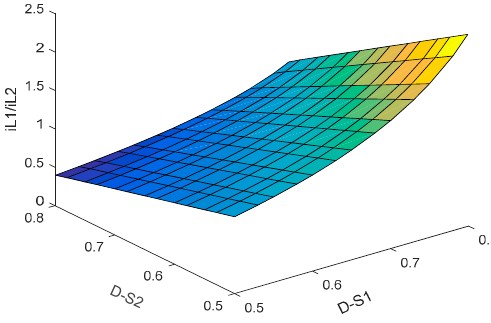
Figure 7. i L 1 / i L 2 3D graph (Discharging Mode (Boost)).